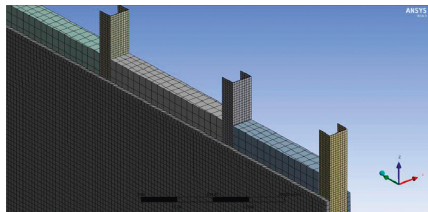
Figure 8: Numerical model of meshing.